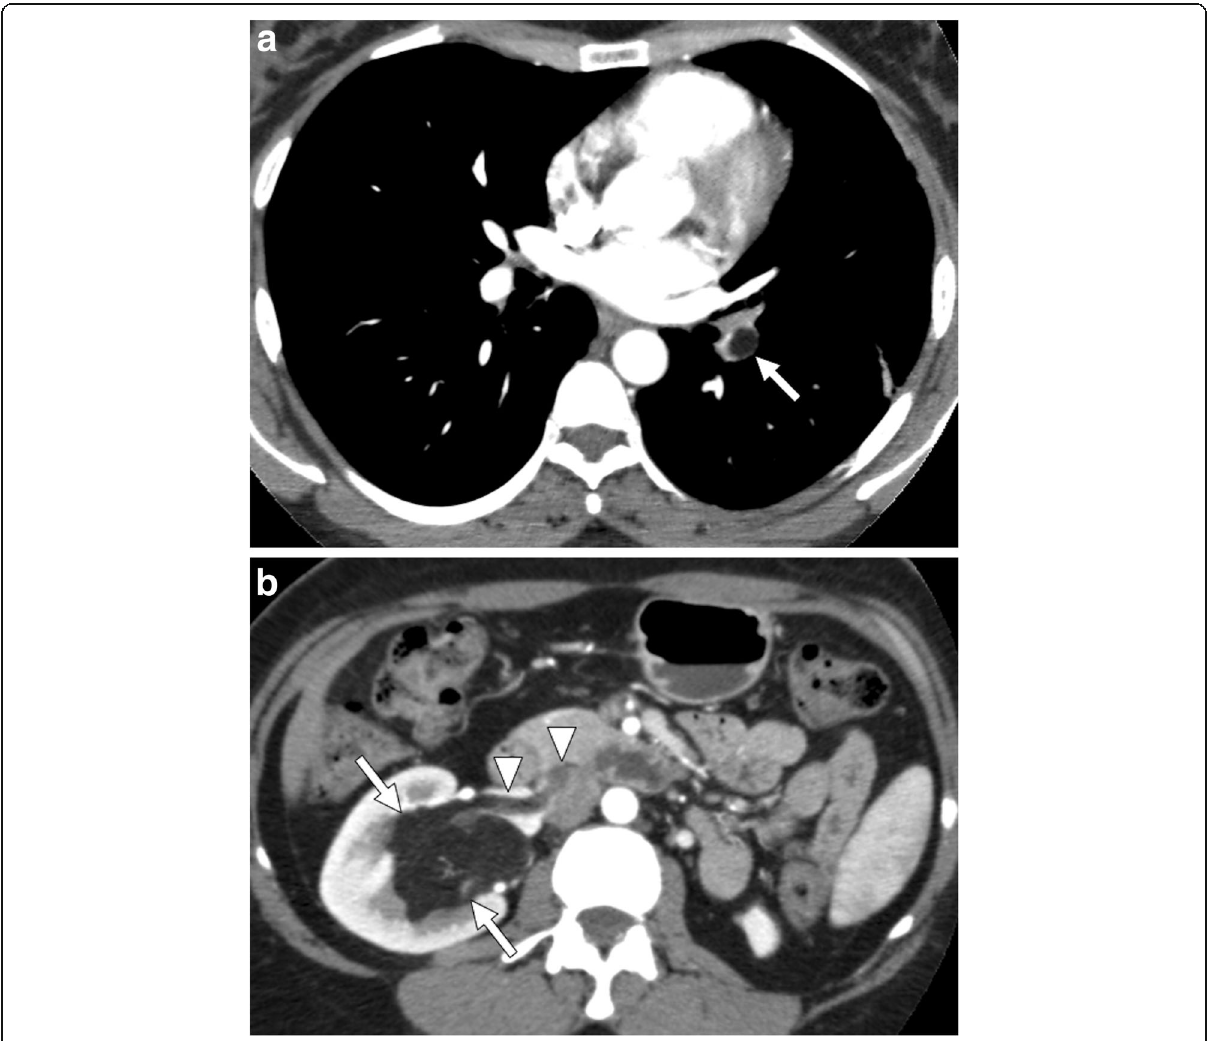
Fig. 17 Tumor thrombus from renal AML. A 42-year-old man with no past medical history now present with acute shortness of breath and hematuria. a Pulmonary CT angiography demonstrates an endoluminal thrombus of macroscopic fat density (arrow) within the left lower lobe pulmonary artery. b Subsequent abdominal CT detected angiomyolipoma (arrows) in the right kidney with tumoral thrombus (arrowheads) in the right renal vein and